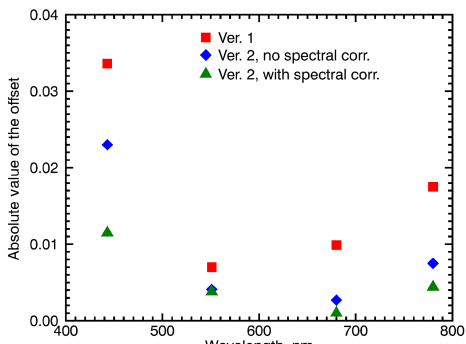
Figure 7. The absolute values of the regression offsets for versions 1 and 2 data with and without spectral correction. Note that the absolute values of offset are reduced due to both the stray light and the spectral corrections for all channels.